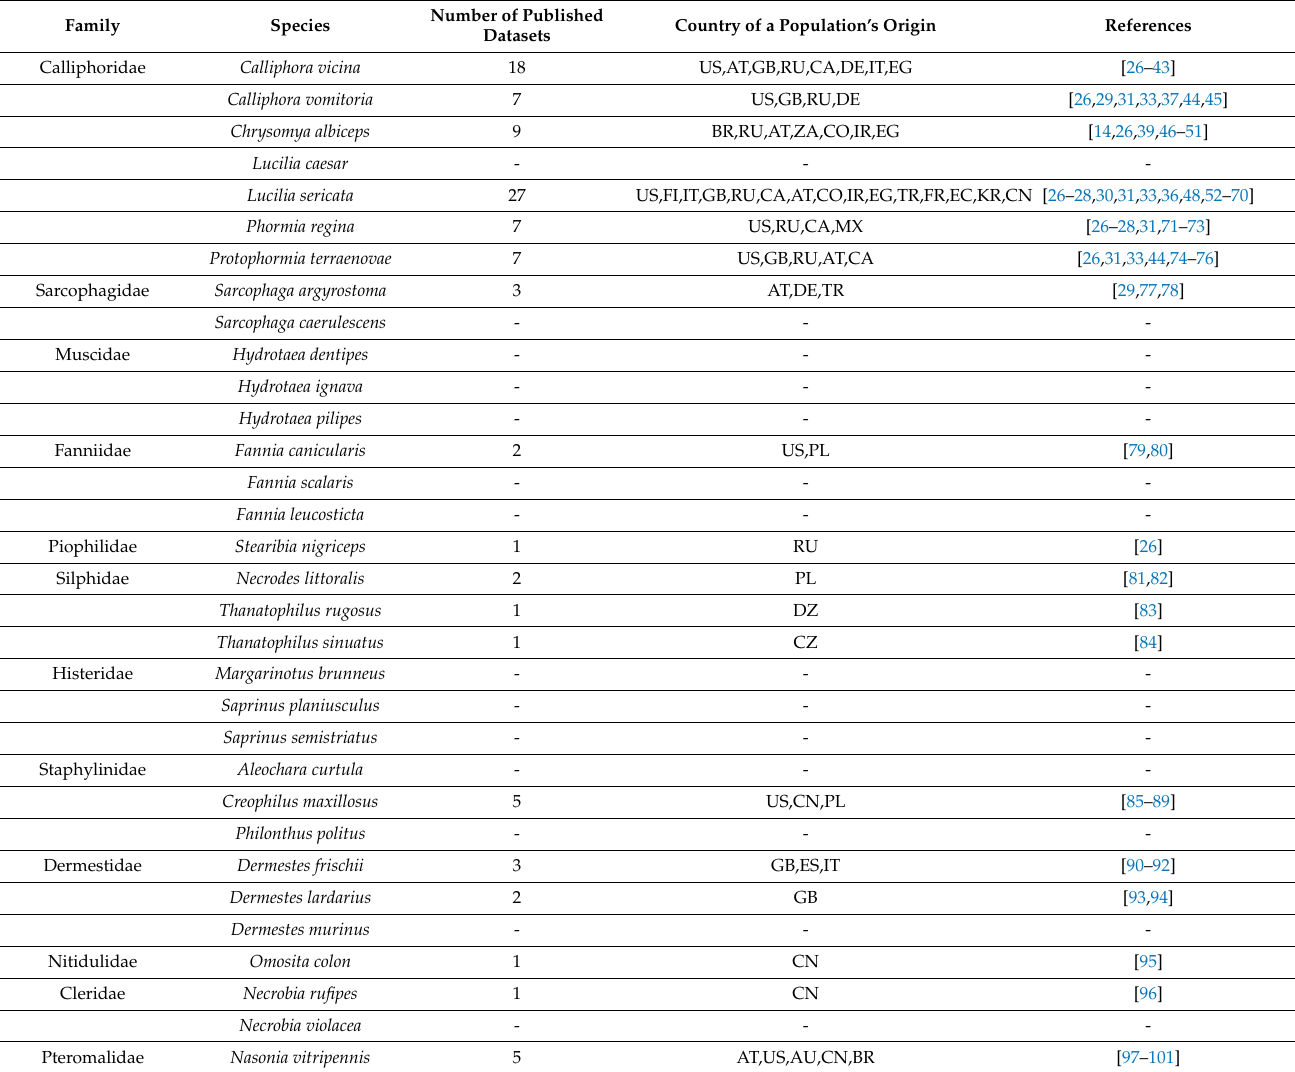
Table 2. Developmental datasets available for the species that breed in large vertebrate cadavers in central Europe (species list compiled based on